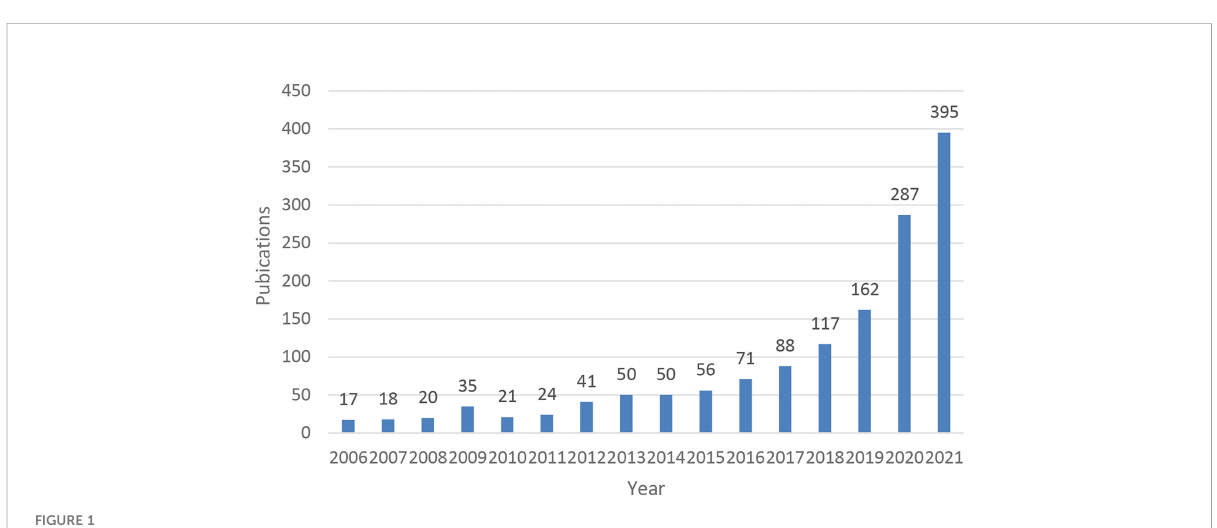
FIGURE 1 Distribution map of literature on sustainable development of the blue economy.